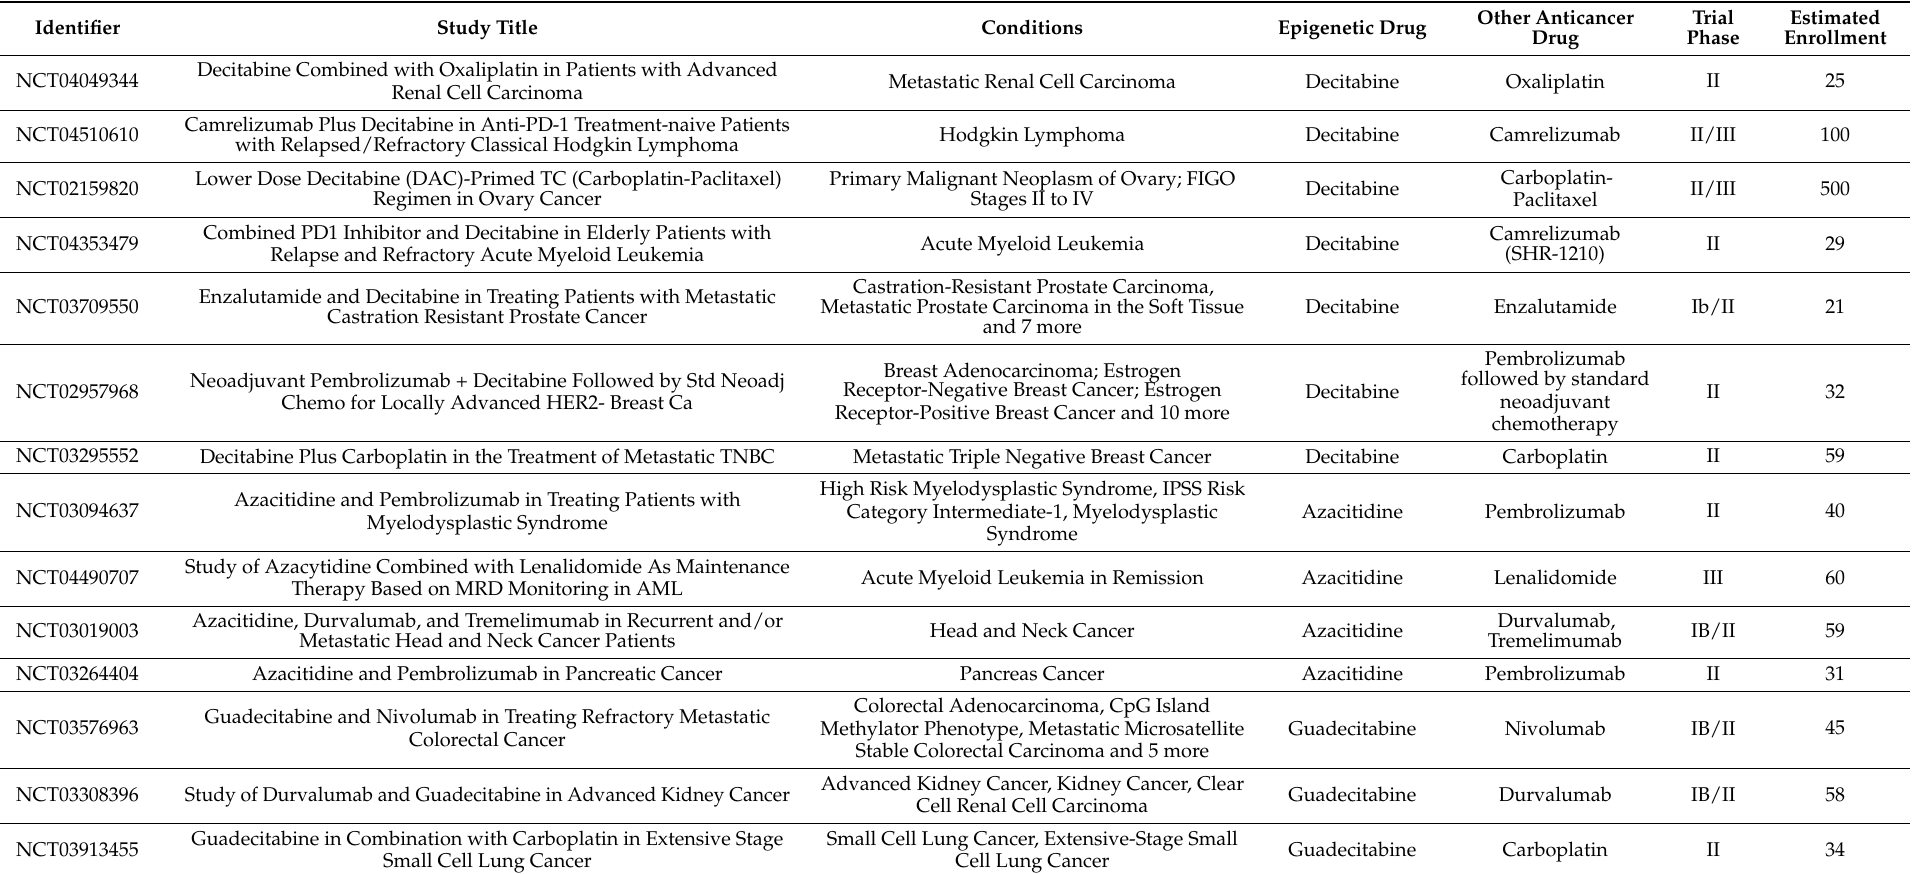
Table 1. Ongoing (recruiting or not yet recruiting) clinical trials of combined epigenetic drug (DNMTi) and other anticancer therapeutic agents (e.g., chemotherapy and